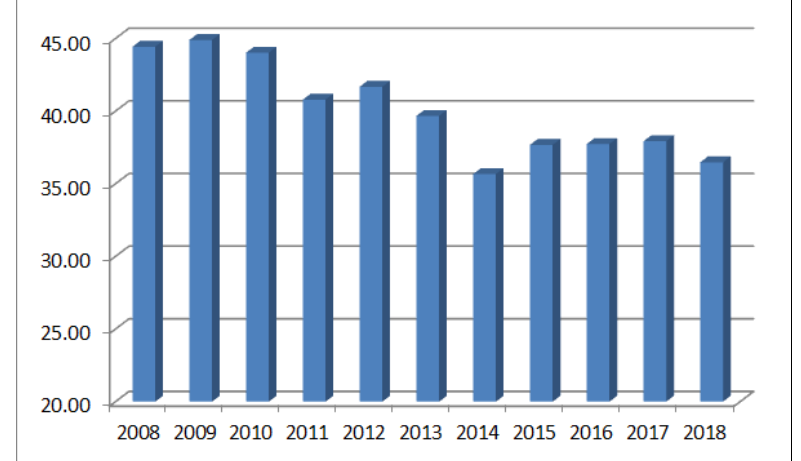
Figure 2. Greenhouse gas emissions in accommodation and food service activities, EU-27, 2008–2018 (kg per capita). Source: Authors’ own contribution, based on data provided by